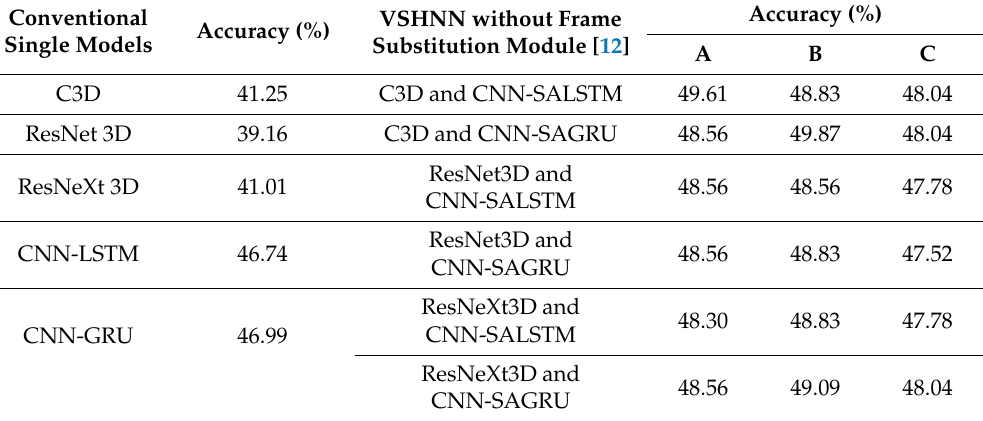
Table 2. Performance evaluation of various models for AFEW dataset. VSHNN without frame substitution module indicates [12]. The CNN in conventional single models is DenseNet121-FC. Bold indicates the best of each row.